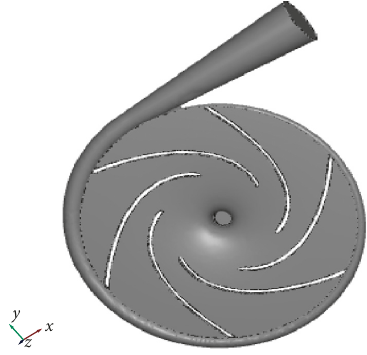
Figure 1: Fluid domain model.